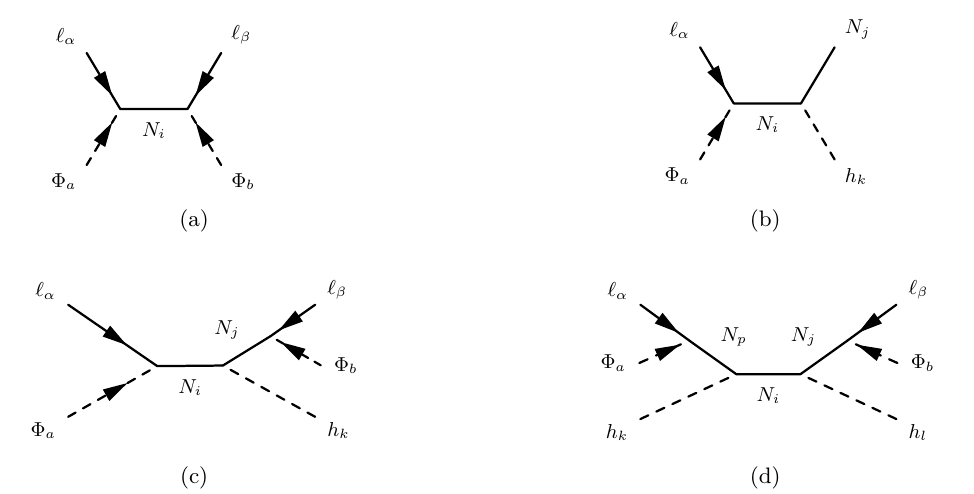
Figure 4 . Scattering diagrams containing real intermediate states (RIS). These must be subtracted in order to avoid inconsistent source terms in the BEs (see text for details). (a) Usual ∆ L = 2 scattering ‘ Φ Φ † s -channel contribution ∼ O ( Y 4 ) . (b) New ∆ L = 1 scattering ‘ α Φ a ↔ N 1 h k α a ↔ ‘ β b s -channel contribution ∼ O ( Y 2 ∆ 2 ) . (c) New ∆ L = 2 scattering ‘ α Φ a ↔ ‘ β Φ †